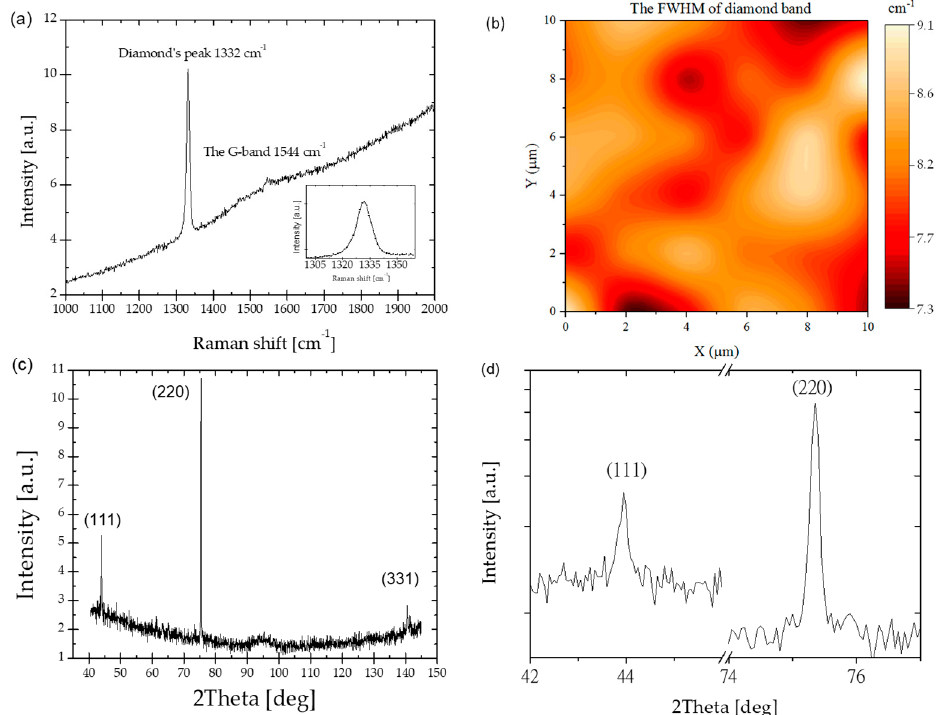
Figure 2. The structural analysis of diamond layers, ( a ) the Raman spectrum, in the insert, details of the diamond peak, ( b ) Raman’s mapping of the FWHM, ( c ) XRD diffractogram of the investigated diamond, and ( d ) details of the two most prominent diffraction peaks.